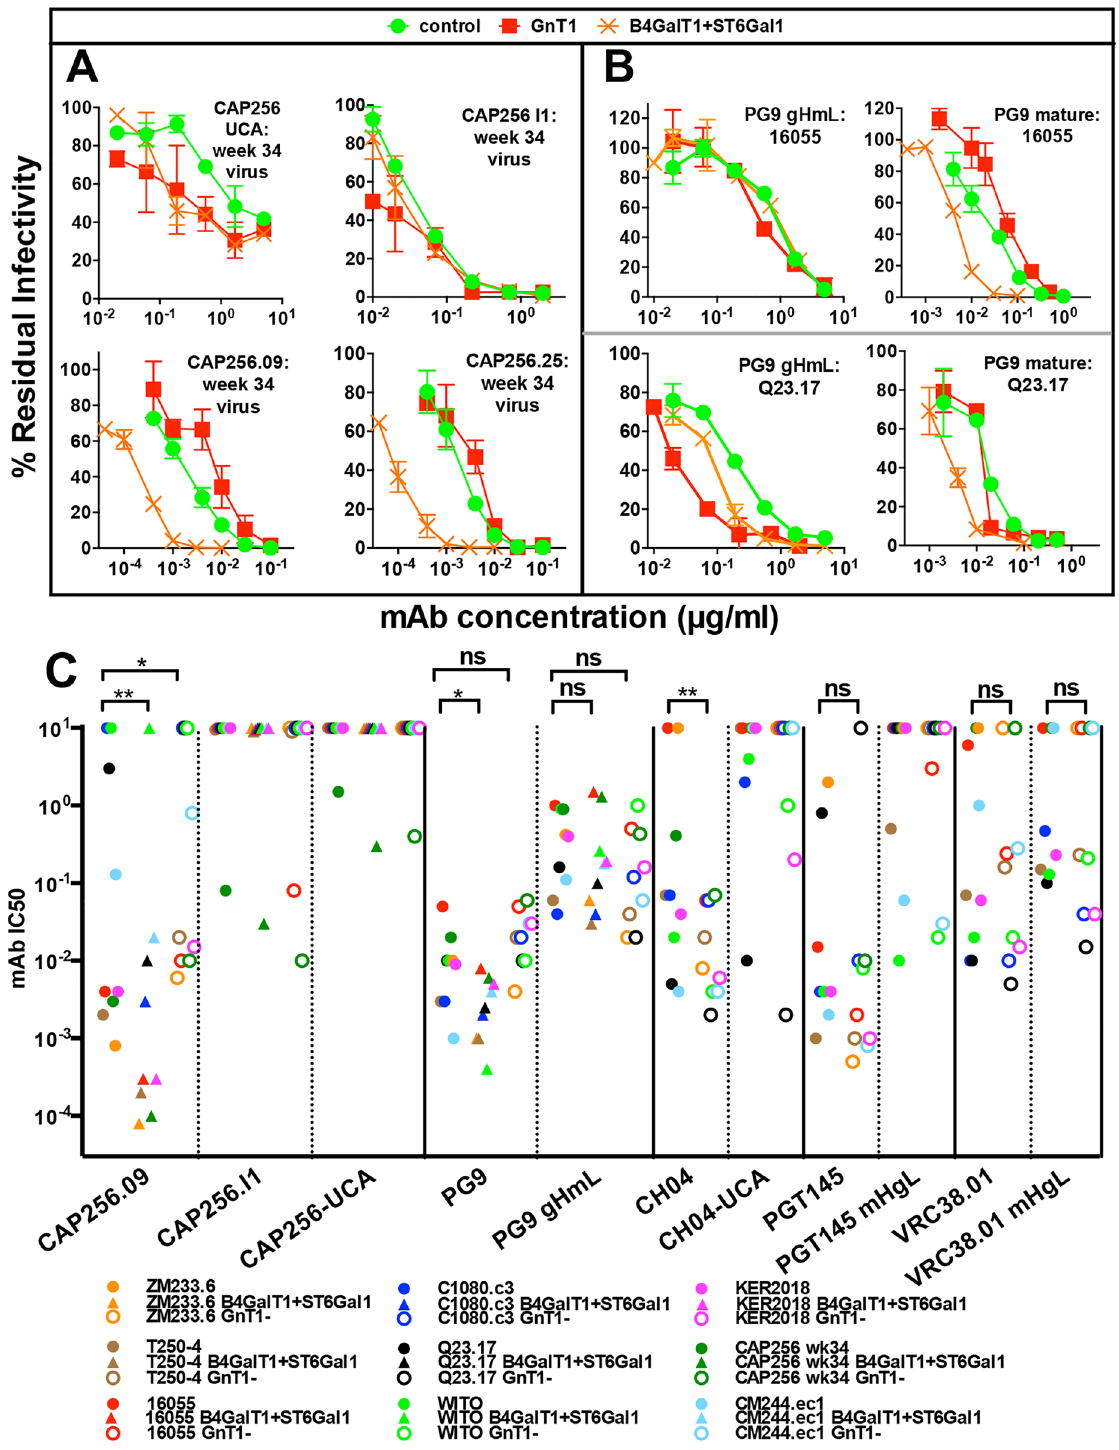
Fig 8. Glycan contacts of mature bnAbs are not germline-encoded. A) GE PVs from donor CAP256 [35] at week 34 were tested for neutralization sensitivity to bnAbs CAP256.09, CAP256.25, intermediate I1 and the inferred unmutated common ancestor (UCA). B) GE- modified 16055 and Q23.17 PVs were tested for sensitivity to PG9 with a reverted heavy chain (gH) mixed with the mature light chain (mL) and fully mature PG9. Results are representative of two replicates; error bars represent SD. C) Nine V2-sensitive strains [34, 36, 45] produced in control, B4GALT1+ST6GAL1 and GNT1- formats were tested for sensitivity to V2 bnAbs and their germline revertants, as indicated.